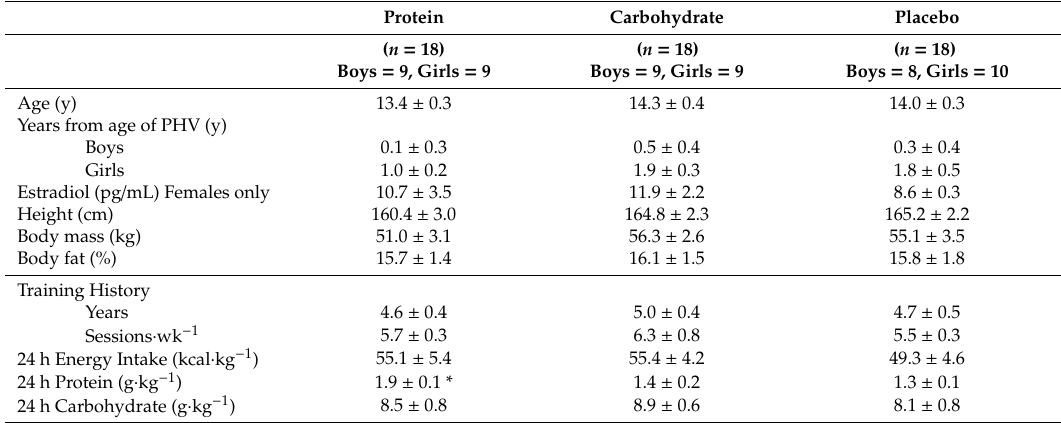
Table 1. Participants’ physical and training characteristics and 24 h energy and macronutrient consumption.